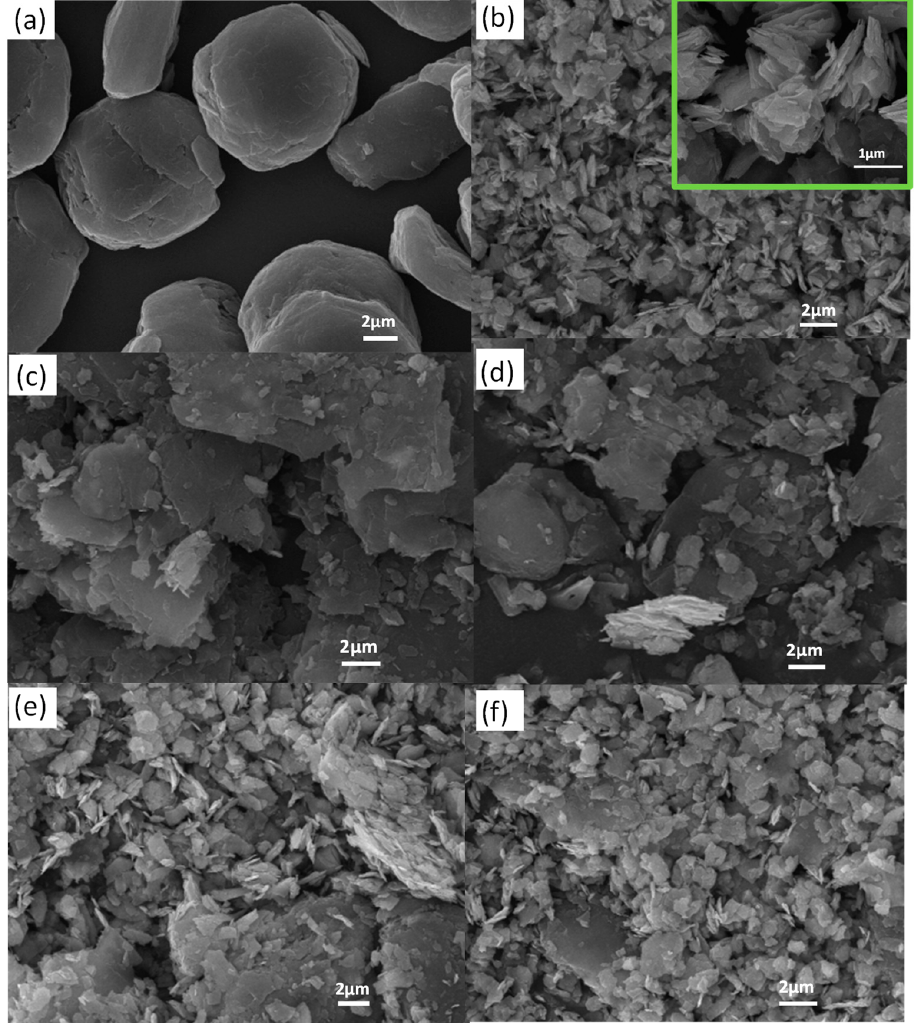
Figure 2. SEM images: ( a ) Graphite; ( b ) MoS 2 (The image obtained after zooming in is shown in the green box); ( c ) MoS 2 /graphite (20%:80%); ( d ) MoS 2 /graphite (40%:60%); ( e ) MoS 2 /graphite (60%:40%); ( f ) MoS 2 /graphite (80%:20%).